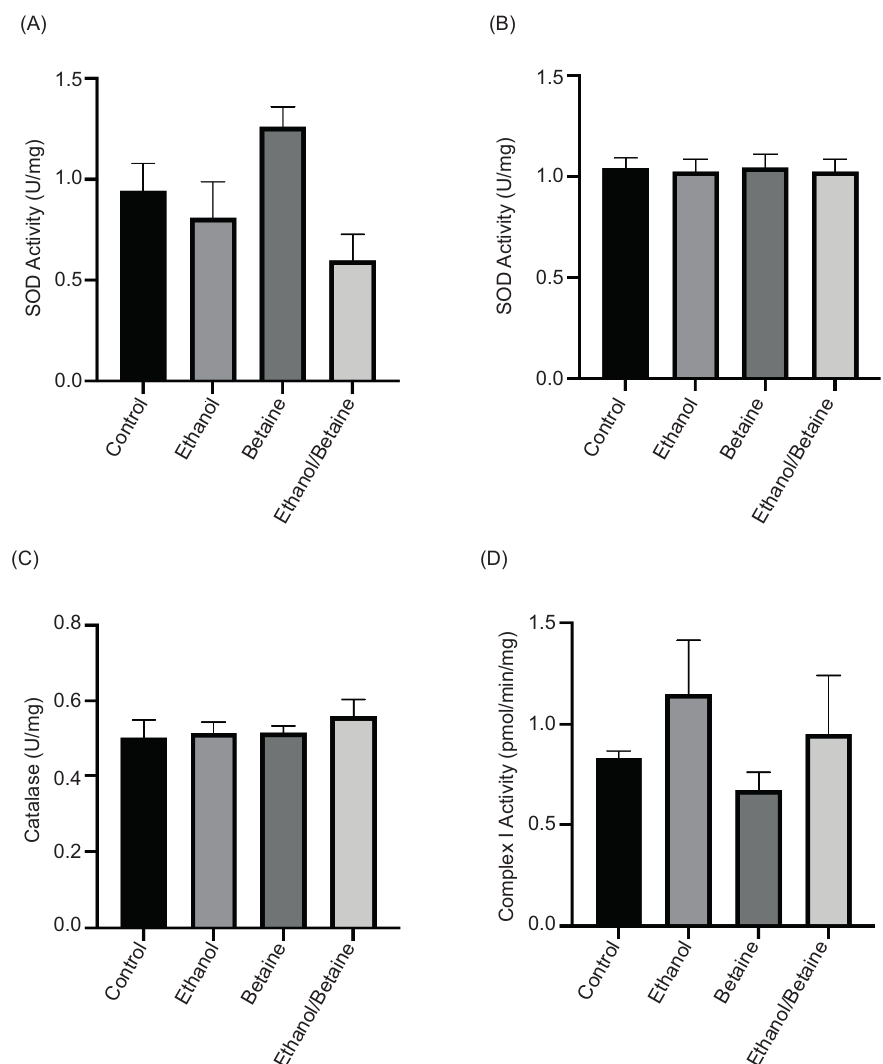
Figure 4: The effect of betaine on ethanol-induced changes in (A) cytosolic SOD activity, (B) mitochondrial SOD, (C) catalase activity, and (D) complex I activity. Following treatment, liver mitochondrial and cytosolic fractions were prepared as previously described and the antioxidant enzyme activity was determined as described in the methods. Values are expressed as mean ± SEM (n =